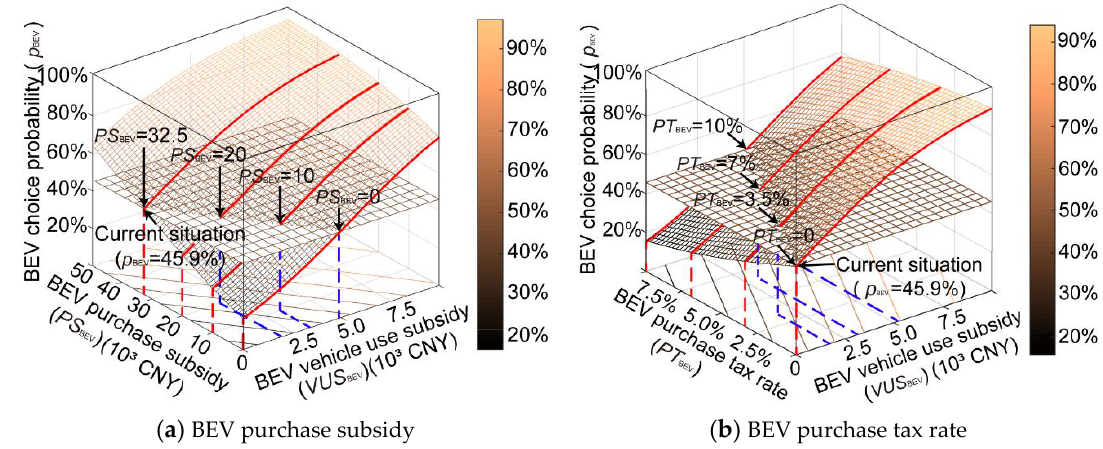
Figure 9. Alternative effects of the vehicle use subsidy (VUS) against purchase subsidy policy phase- Figure9. Alternativee ff outs.